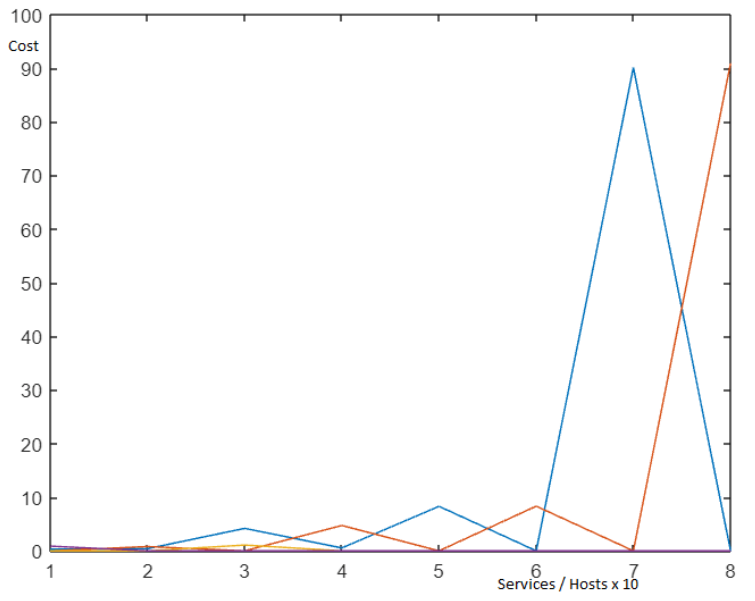
Figure 11. Linear programming matrix